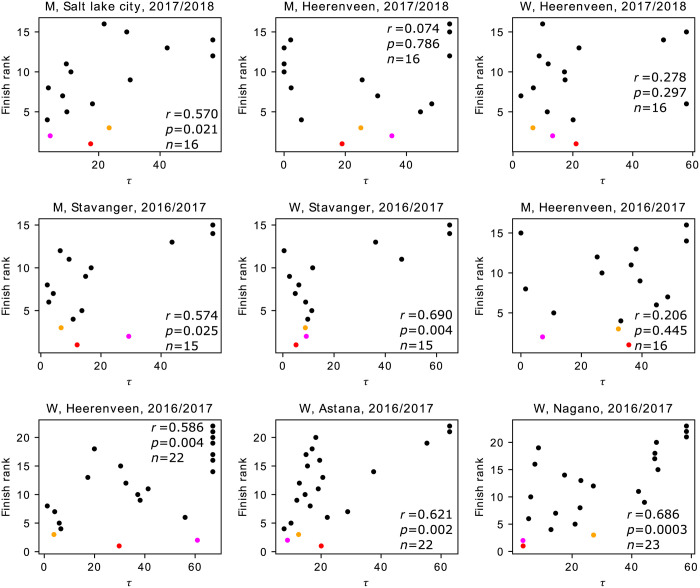
Relationships between the finish rank and τ.Each panel represents a race. A circle represents a skater. The top three finishers are shown in red, magenta, and orange. The Pearson correlation coefficient, r, its p value, and the sample size (i.e., number of skaters in the race), n, are also shown. M: men. W: women.